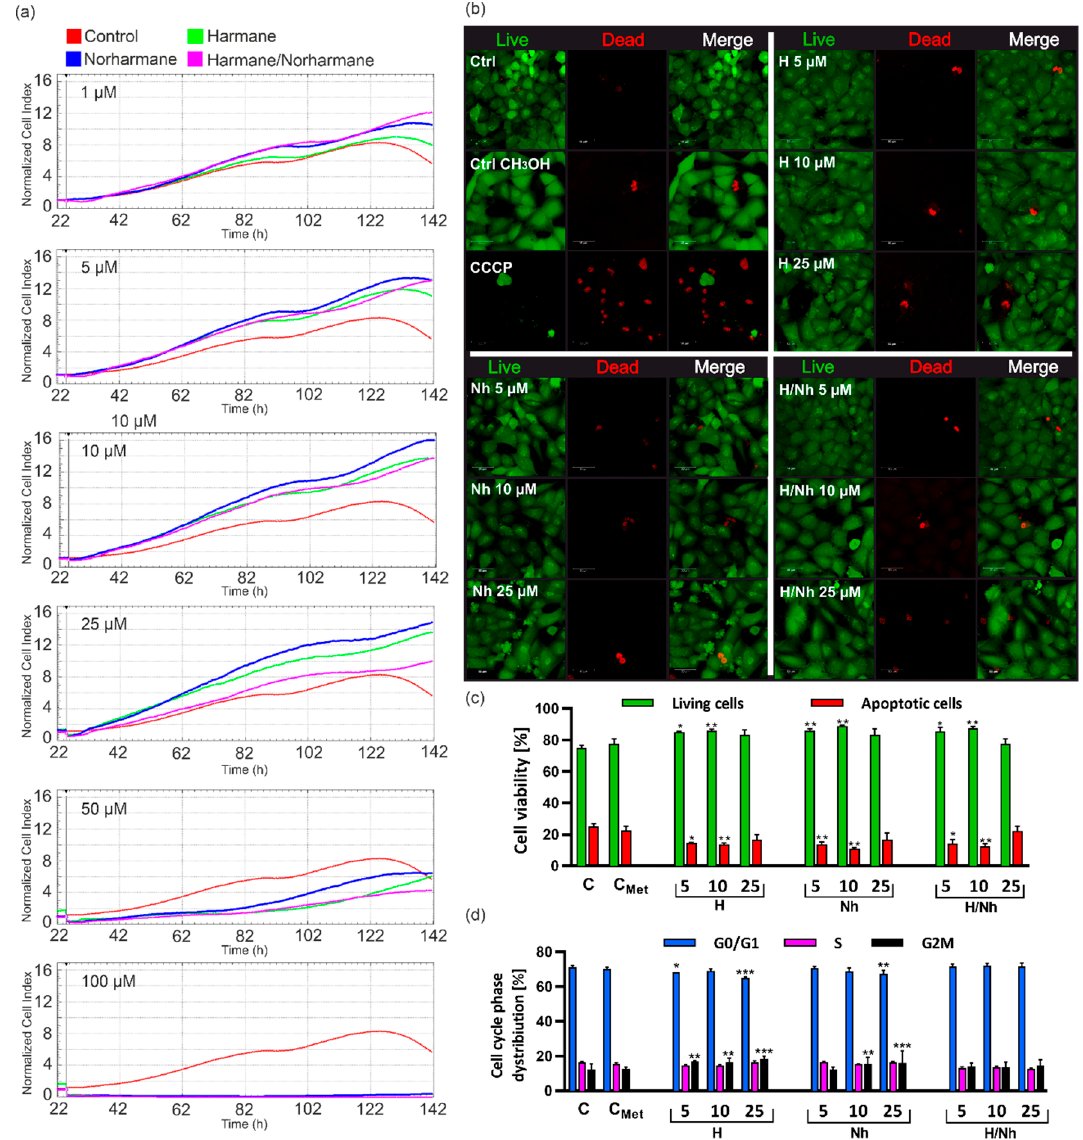
Figure 2. Viability analysis of aged human cells after harman and norharman treatment. ( a ) Real-time analysis of MRC-5 cells (passage 19, aged cells) proliferation by the xCELLigence system for 6 days in the presence of 1, 5, 10, 25, 50, and 100 µ M harmane (H), norharmane (NH) or a mix of both (H / NH). Proliferation was monitored in 30 min intervals. Vertical lines on the graphs indicate the time points for adding compounds. Normalized Cell Index (NCI) = CI original / CI normalize time . ( b ) Confocal microscopy analysis of MRC-5 viability using LIVE / DEAD assay kit. Panels with green (Ex / Em 495 / 515 nm) and red fluorescence (Ex / Em 530 / 635 m) show live and dead cells, respectively. Merged images are presented on the right panel. ( c ) Flow cytometry analysis of apoptosis in MRC-5 cells treated with 5, 10, and 25 µ M after 24 h with Casp 3 / 7-FITC / 7-AAD dual staining. ( d ) Flow cytometry analysis of H, NH, and H / NH e ff ect (5, 10, and 25 µ M) of on the cell cycle phase distribution in MRC-5 cells after 24 h. The data are presented as the mean ± SEM (standard error of the mean) from three independent experiments. Statistical significance (ANOVA): (*) p < 0.05, (**) p < 0.01, (***) p < 0.001. The greatest proliferation rate was obtained for the NH and H / NH mix used at final concentrations of 1, 5, and 10 µ M. For 25 µ M of H / NH mix, a significant decrease in the proliferation level was observed compared to the results received for H or NH, used separately, and remained on the control cell